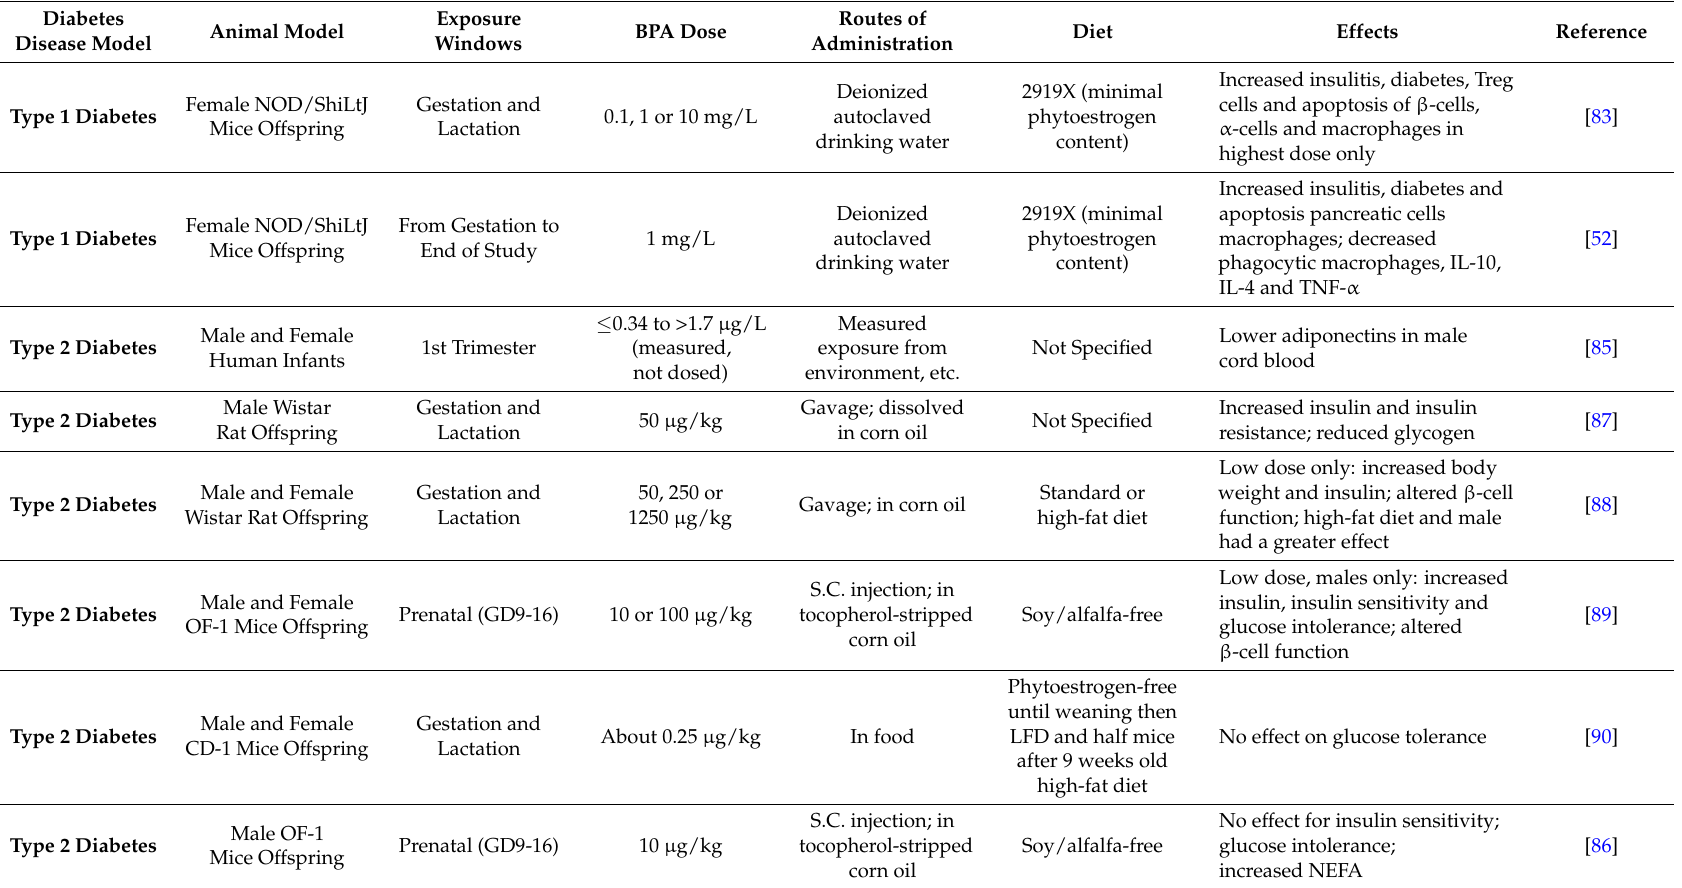
Table 2. Summary of animal diabetes (type 1 and type 2) studies on BPA exposed